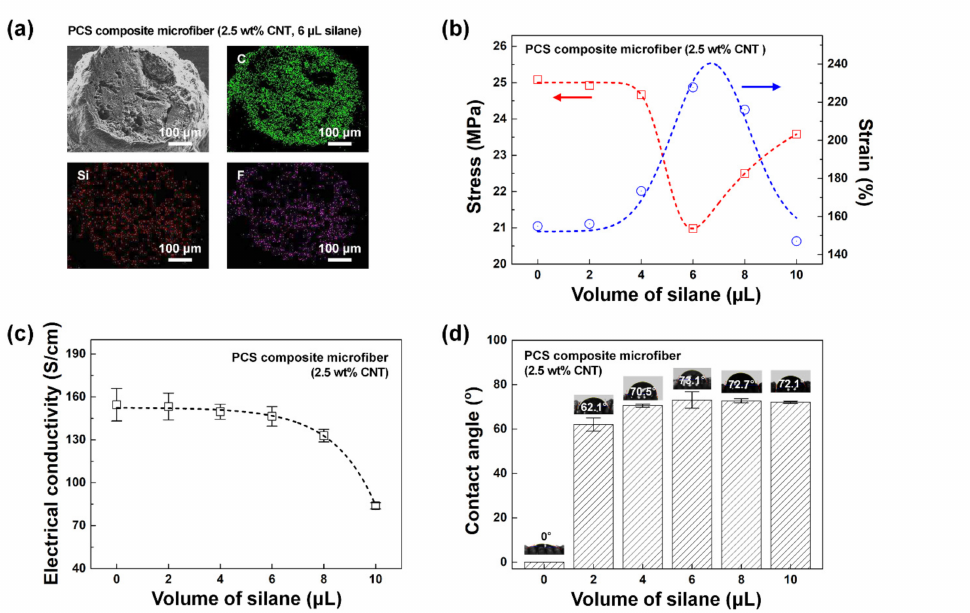
Figure 3. Optical, mechanical, electrical, and wetting properties of PCS composite